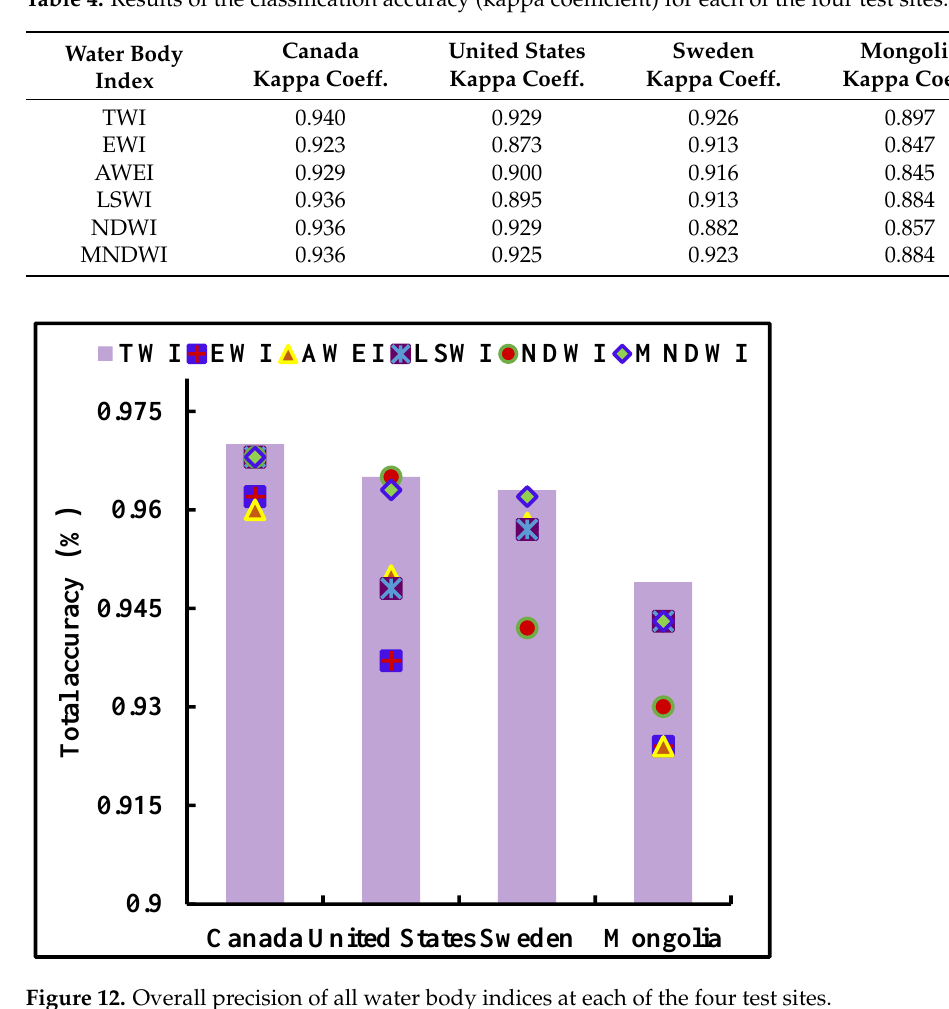
Table 4. Results of the classification accuracy (kappa coefficient) for each of the four test sites.